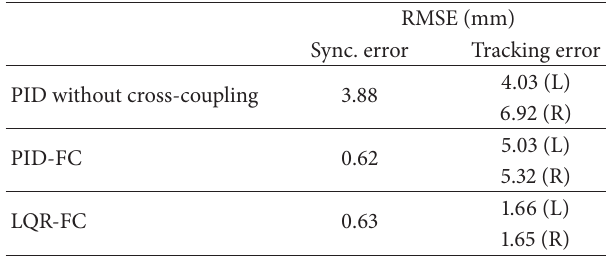
Table 1: Comparison of performance of controllers of sinusoidal